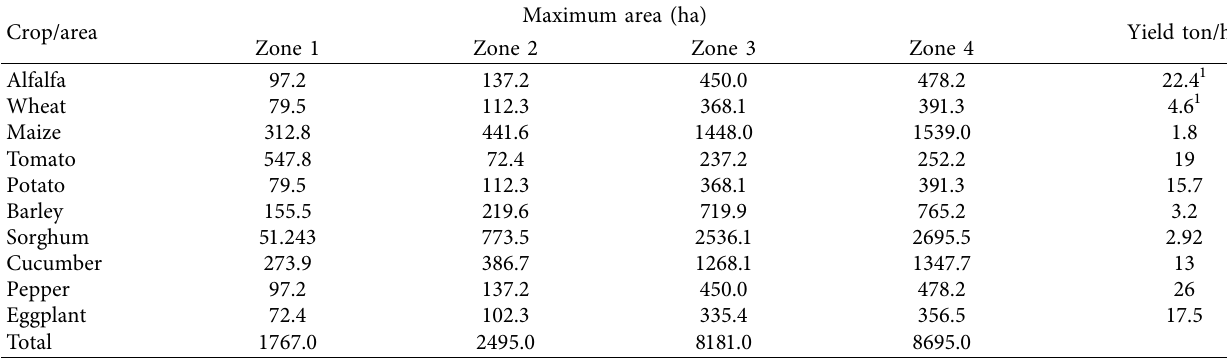
Table 1: Te yield (ton per ha) for each crop along with maximum crop area (ha) for each zone.